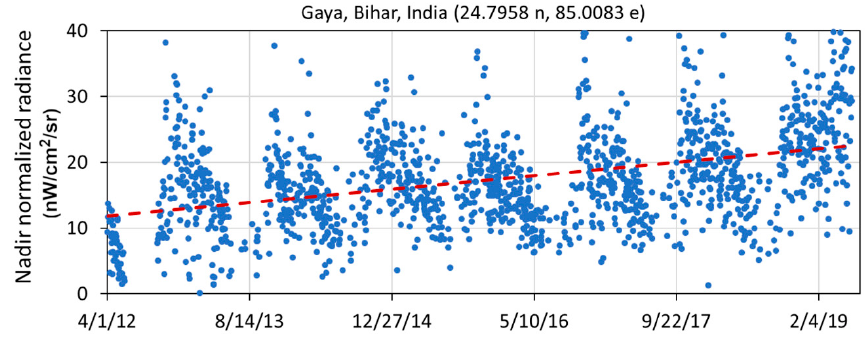
Figure 15. Upward trend in the DNB profile from Gaya, India.